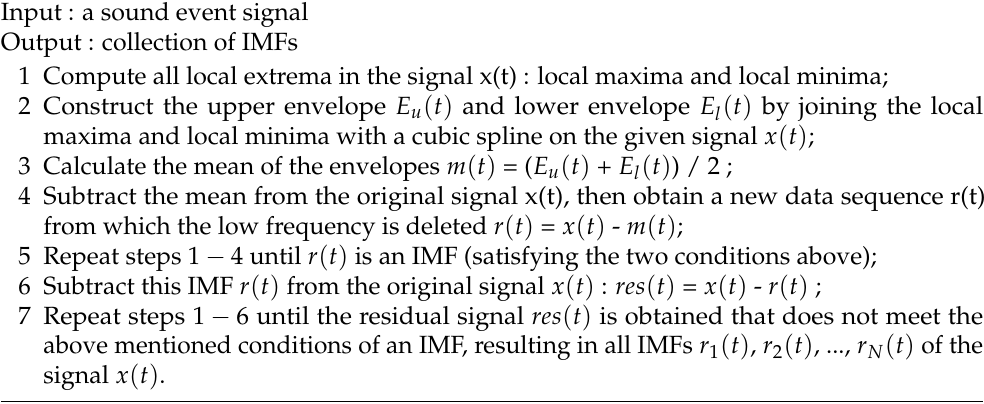
Algorithm 1 Sifting process for intrinsic mode